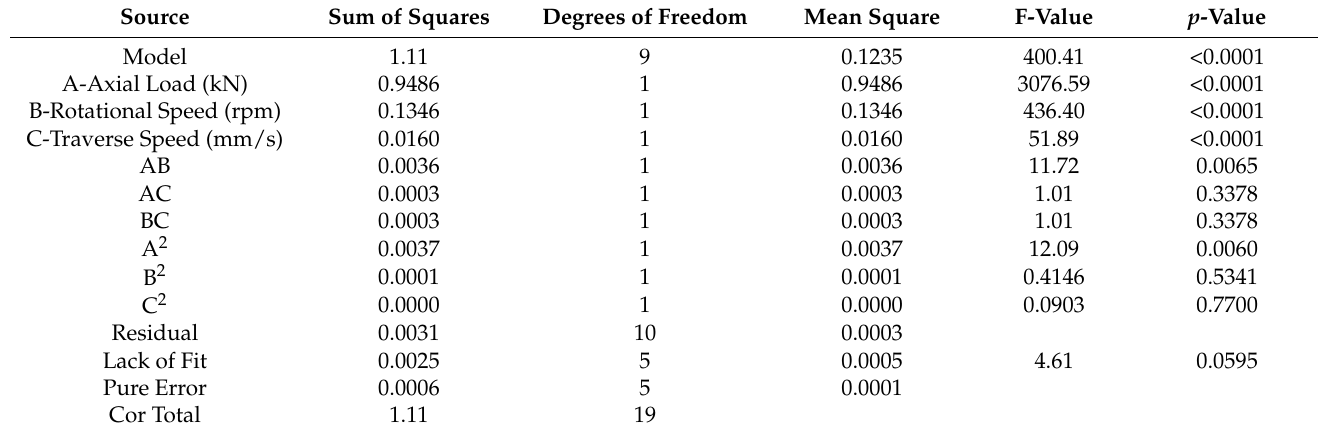
Table 5. ANOVA for quadratic model—Response 1: Coating thickness (C t ).